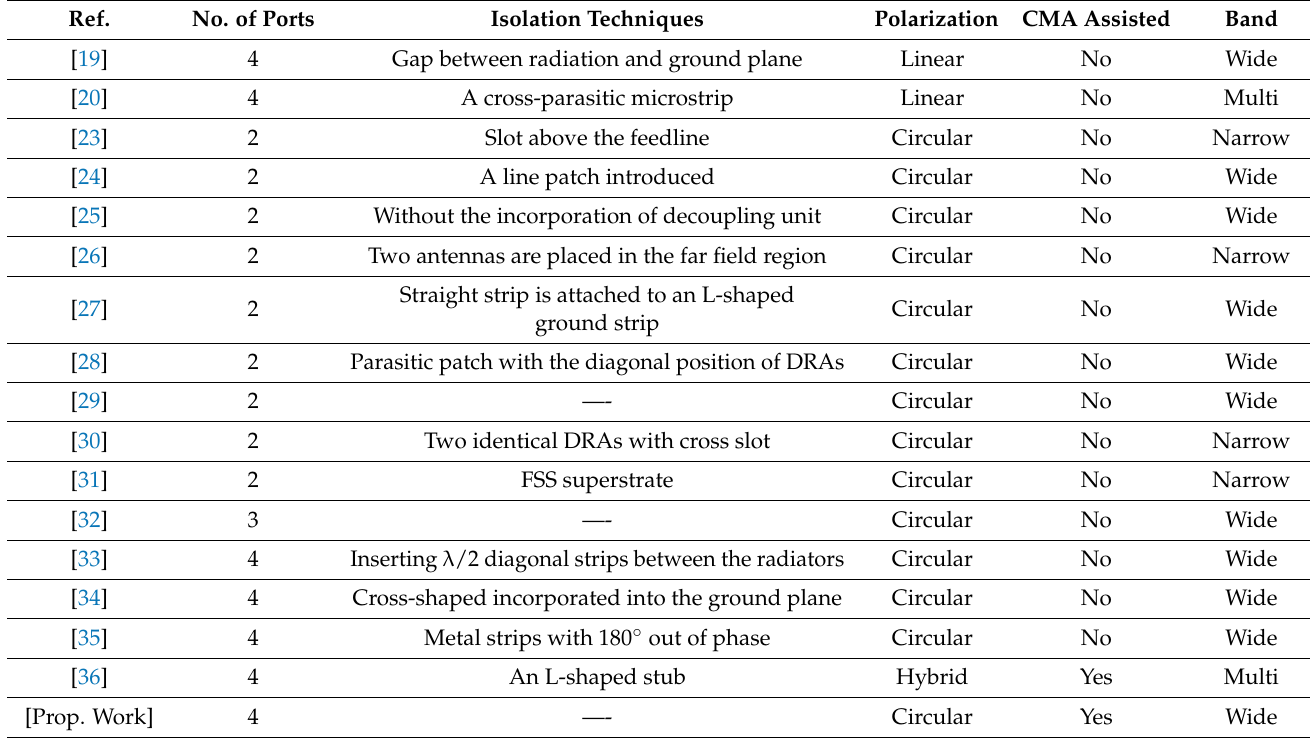
Table 1. Summary of the existing literature.